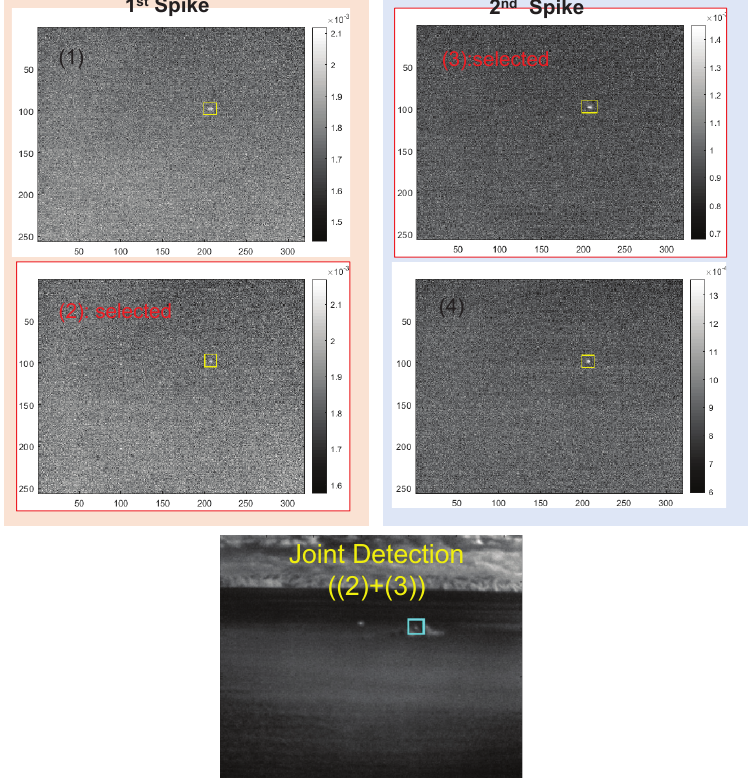
Figure 8. Probed band images of first and second spikes corresponding to (1) and (2), and (3) and (4), respectively. The final target is detected via joint detection from the selected max signature for each